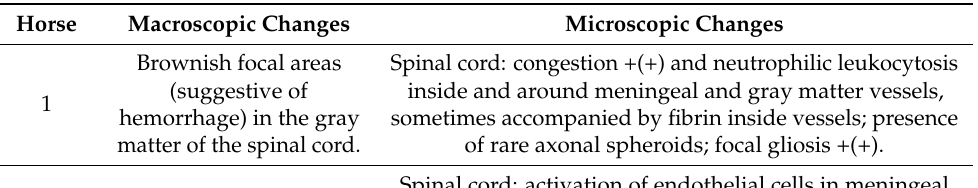
Table 2. Necroscopic and histopathological findings of horses with equine herpesvirus myeloen- cephalopathy in the state of Par á , Amazon,